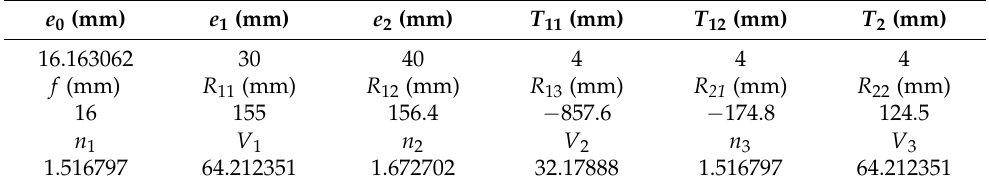
Figure 9. Anamorphic attachment for a Computar 16 mm spherical lens in the YOZ plane. Table 1. Parameters of the anamorphic attachment used for the anamorphic